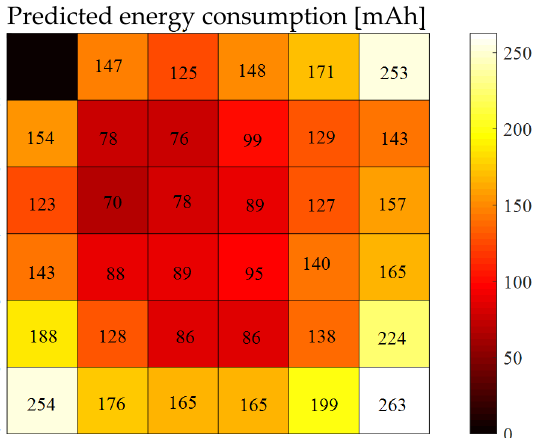
Figure 14. Predicted energy consumption at each intersection for a 6 × 6 grid [mAh] and RW algo-